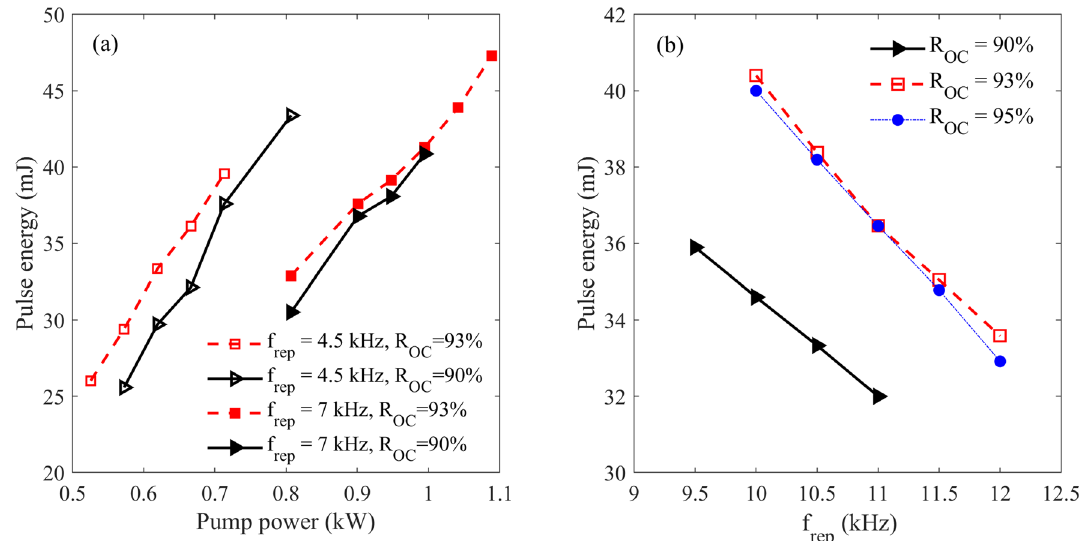
Figure 6. ( a ) The energy of output pulses as a function of a pump power density for different repetition rates and OC couplers. ( b ) The pulse energy as a function of repetition rate for different OCs and at the pump power of 1220 W.